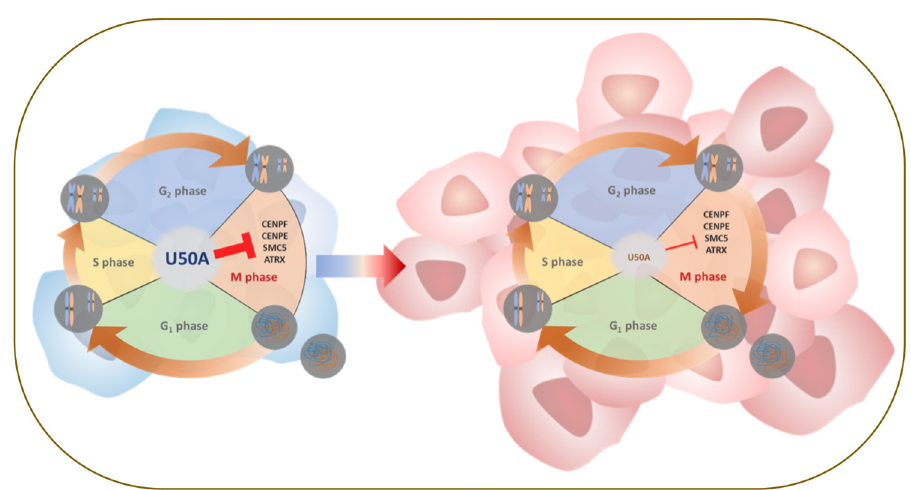
Figure 6. Schematic representation of U50A-prolonged